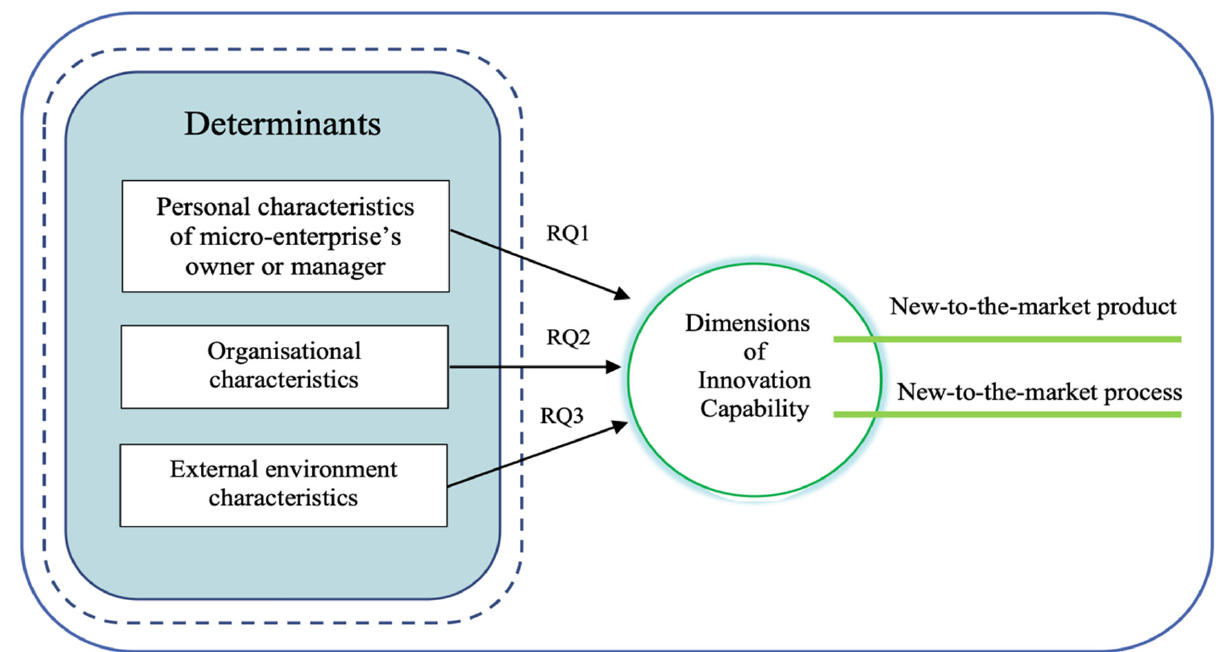
Figure 1. Conceptual model.